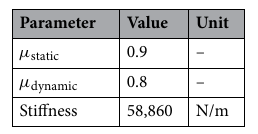
Table 5. Ground contact